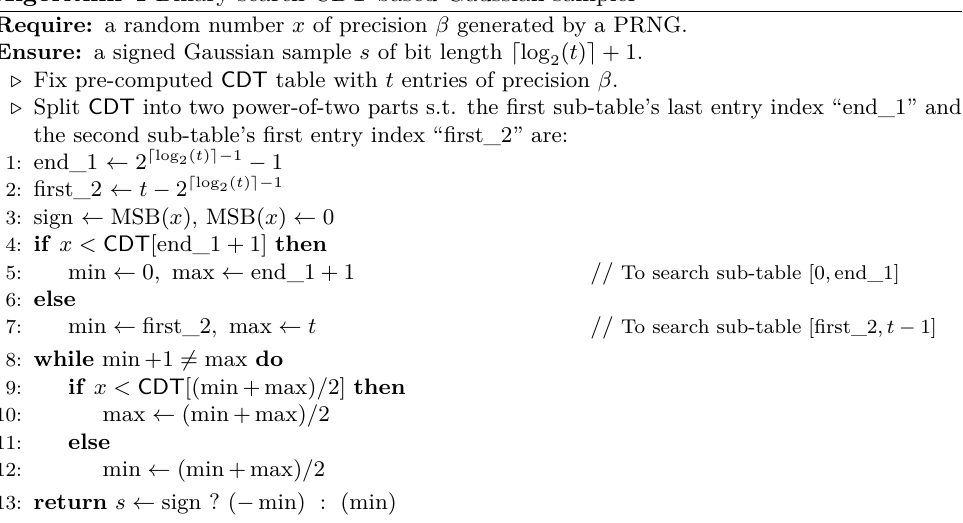
Algorithm 4 Binary-search CDT-based Gaussian